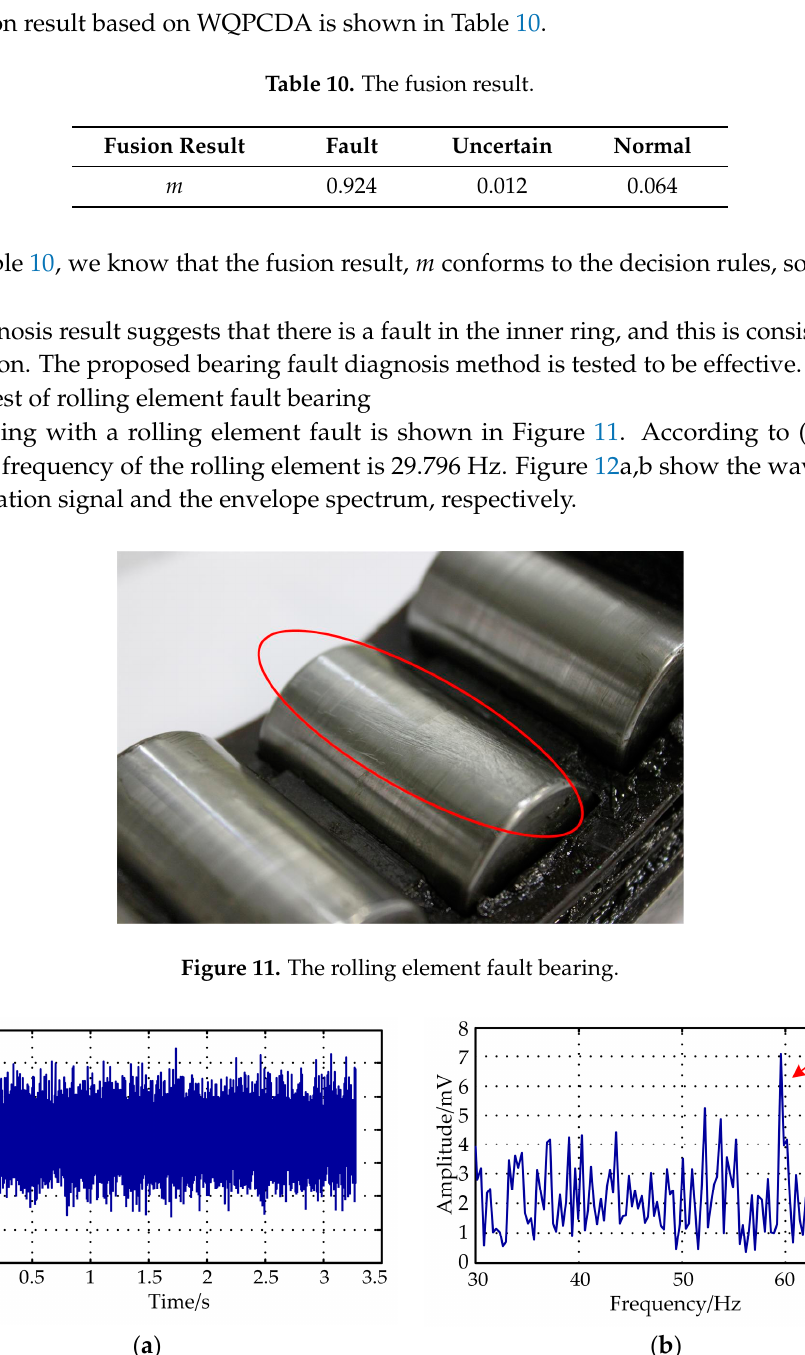
Table 11. The mass functions.